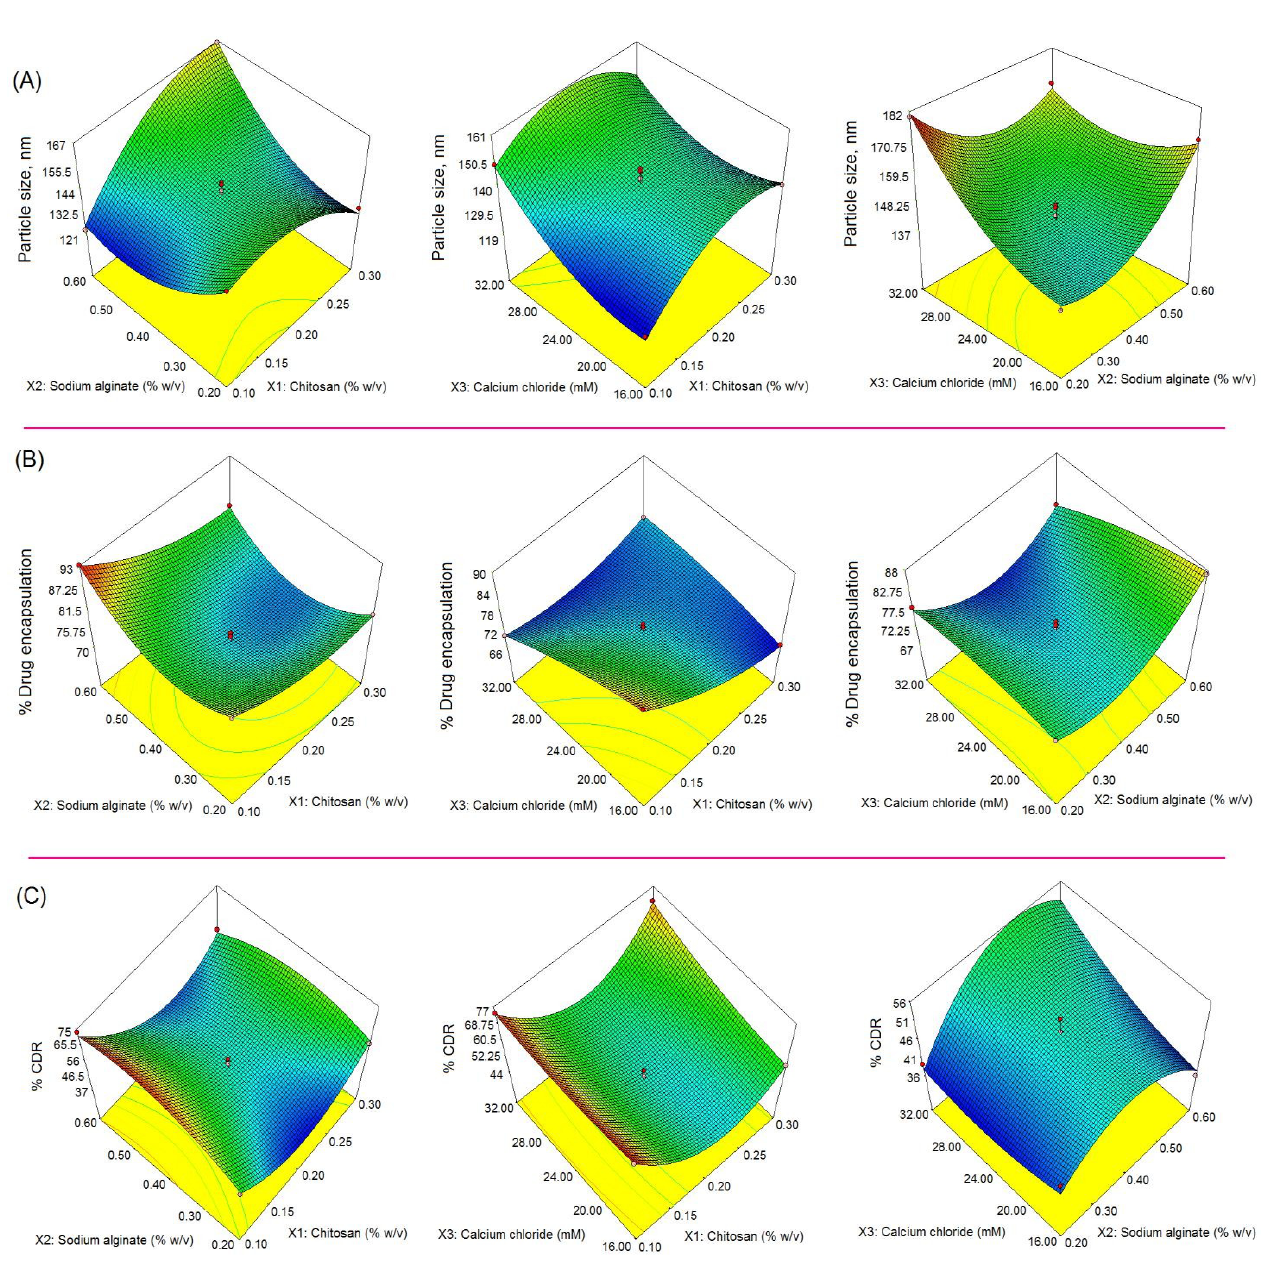
Figure 2. The response-surface curve (3D) ( A – C ) showing the effect of formulation variables: X1: Chitosan (% w / v ), X2: Sodium alginate (% w / v ), and X3: Calcium chloride (mM) on responses, particle size, nm ( A ), %drug encapsulation ( B ), and %cumulative drug release (%CDR) ( C ) of β -SIT-Alg/Ch-NPs-FA.